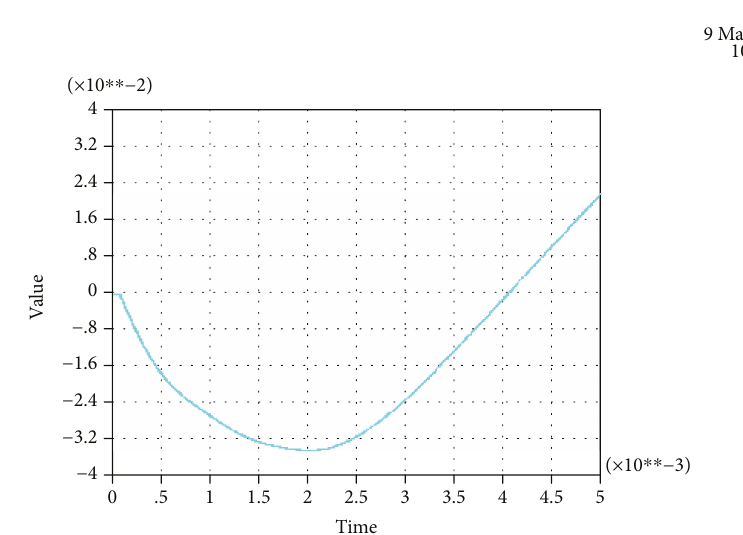
Figure 22: UY displacement